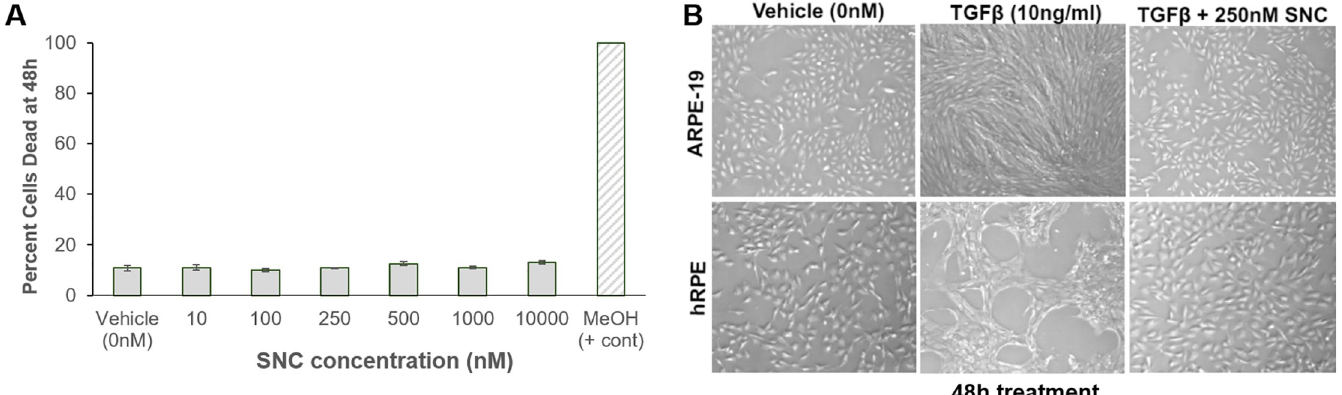
Fig 1. Salinomycin blocks RPE cell EMT with no toxicity. Cells were plated at a density of 10,000 cells/cm 2 in media with 10% FBS for 24 hours, then starved in media with 0.1% FBS for 18 hours prior to vehicle/SNC treatment for 48 hours. A) Cytotoxicity, measured in ARPE-19 cells using a Live-Dead Assay after 48h treatment, showed no apparent increase in cell death over a wide range of SNC concentrations; 70% MeOH was used as a positive control for cell death. Each treatment was performed in triplicate and values were averaged together; similar trends in viability were seen with cells at different passages. B ) Bright-field images of ARPE-19 and hRPE cells show that while TGF β treatment promotes EMT to fibroblasts, 250nM SNC is sufficient to prevent RPE EMT to fibroblasts after 48h.